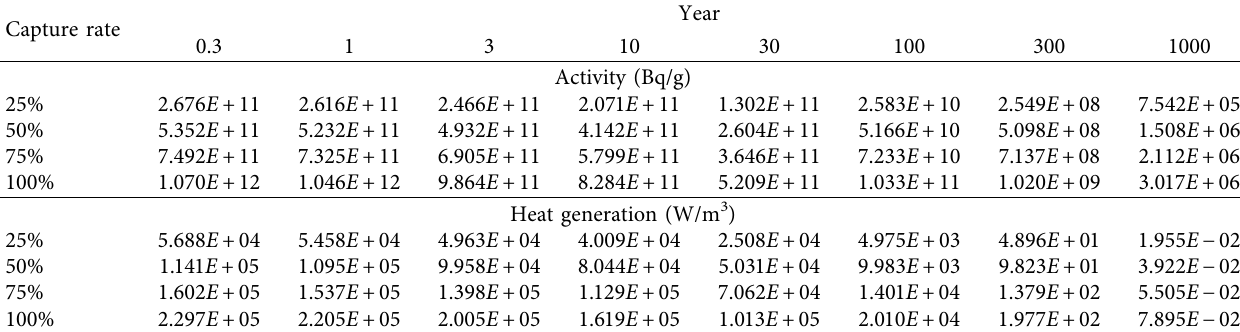
Table 2: Radiological characteristics of Cs waste/waste form according to capture rate.